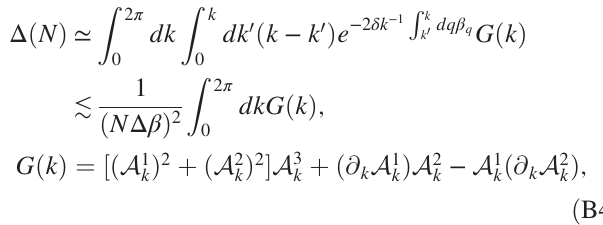
as a function of E accumulated E